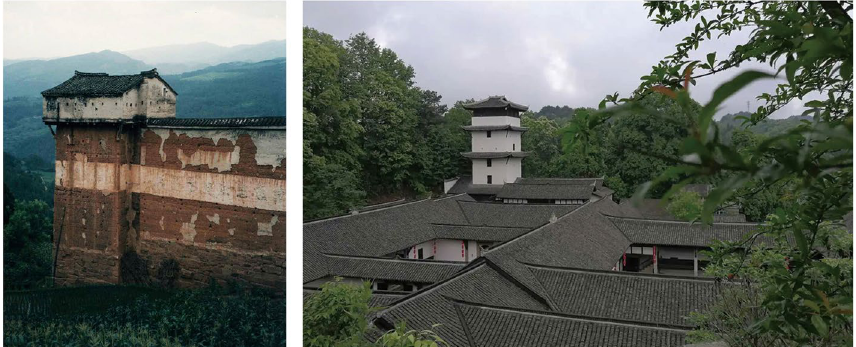
Fig. 3 Vivid image of a rammed earth seven-layer watchtower in Wulong, Chongqing, and a five-layer rammed earth manor watchtower in Huilong Villa, Jiangjing, Chongqing (Source: the